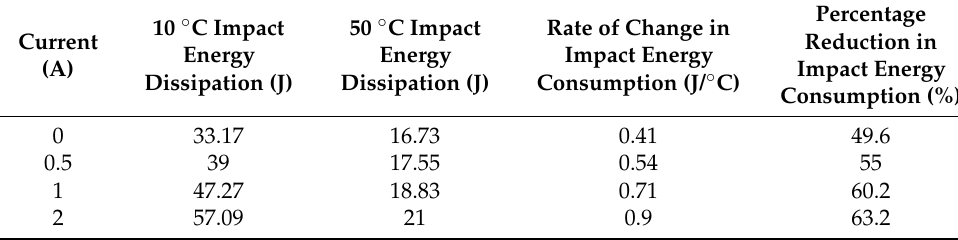
Table 4. Impact energy dissipation affected by